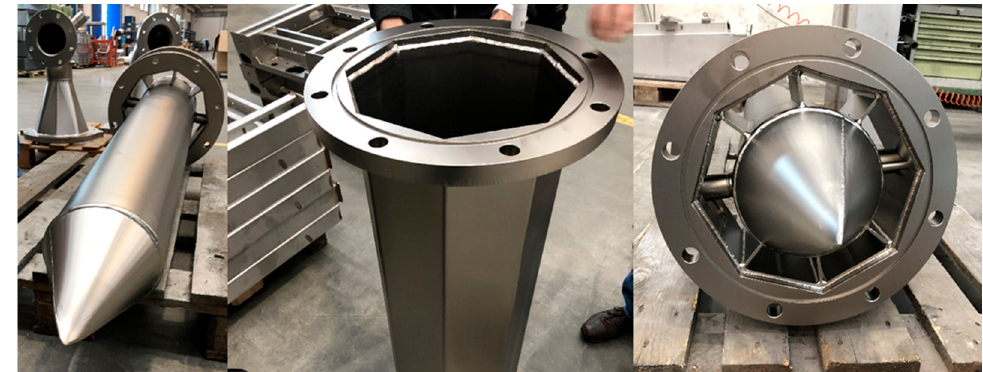
Figure 7. Some phases of the construction of the modular unit of the Sono-Heat-Exchanger—Olive Sound built for optimization tests at the Pieralisi company.